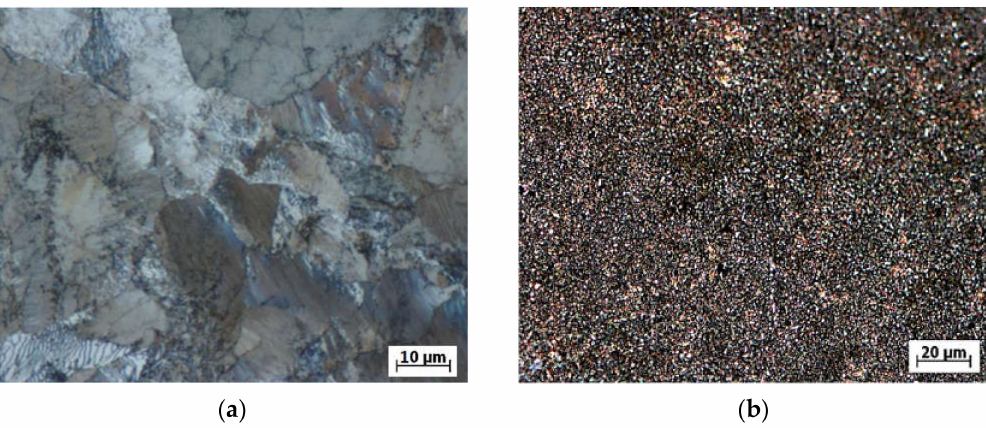
Figure 6. The microstructure of the 100CrMnSi6-4 steel before heat treatment: ( a ) The microstructure of the abrasive roller from the material 100CrMnSi6-4; ( b ) the photo taken in the polarized light, etched by Nital 2%.